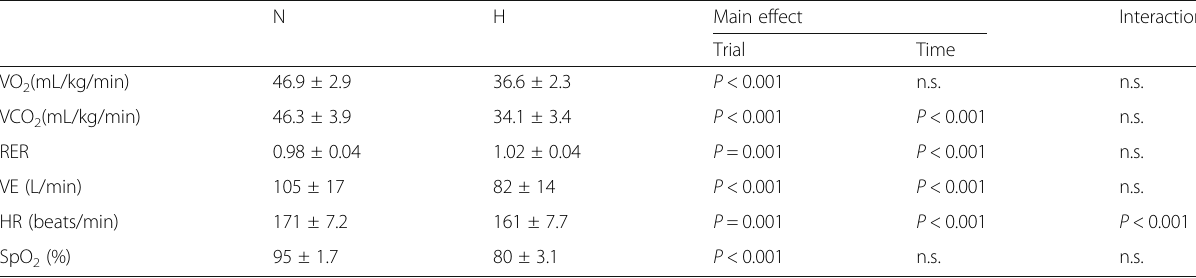
Table 1 Cardiorespiratory variables during